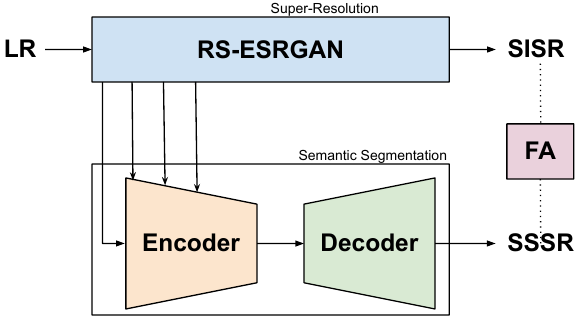
Figure 5. High-level scheme architecture of the